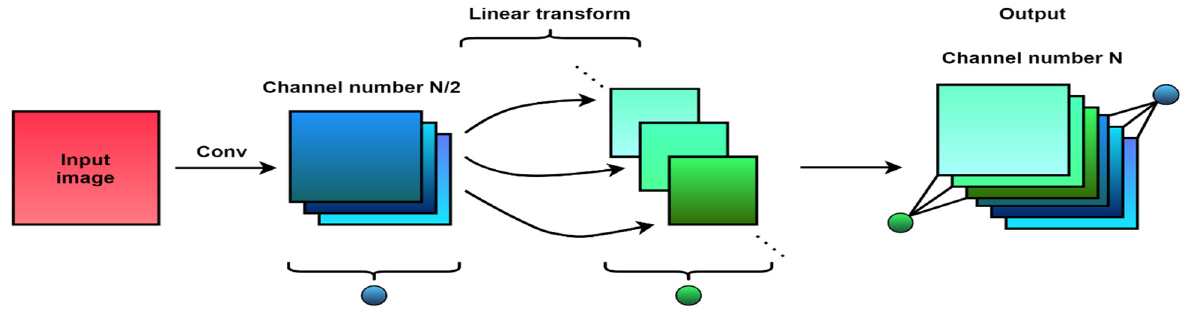
Figure 12. Ghost network structure.